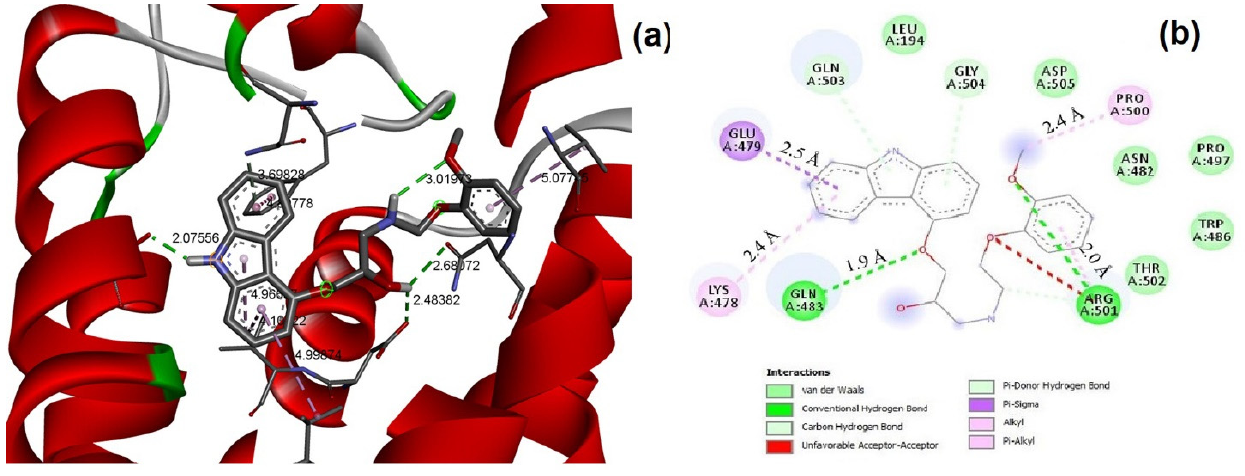
Figure 2. ( a ) The binding mode of β 1 adrenoreceptor active site, and ( b ) Ligplot of β 1 adrenoreceptor active site.